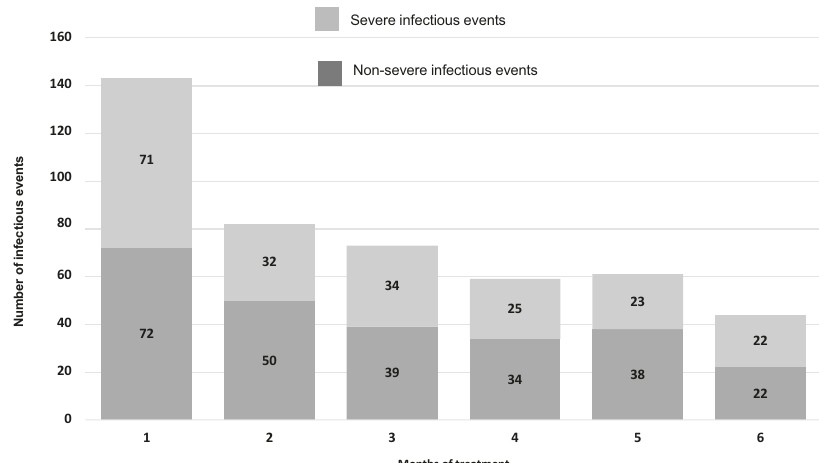
Fig. 1 Distribution of the number of infectious events per month from treatment.